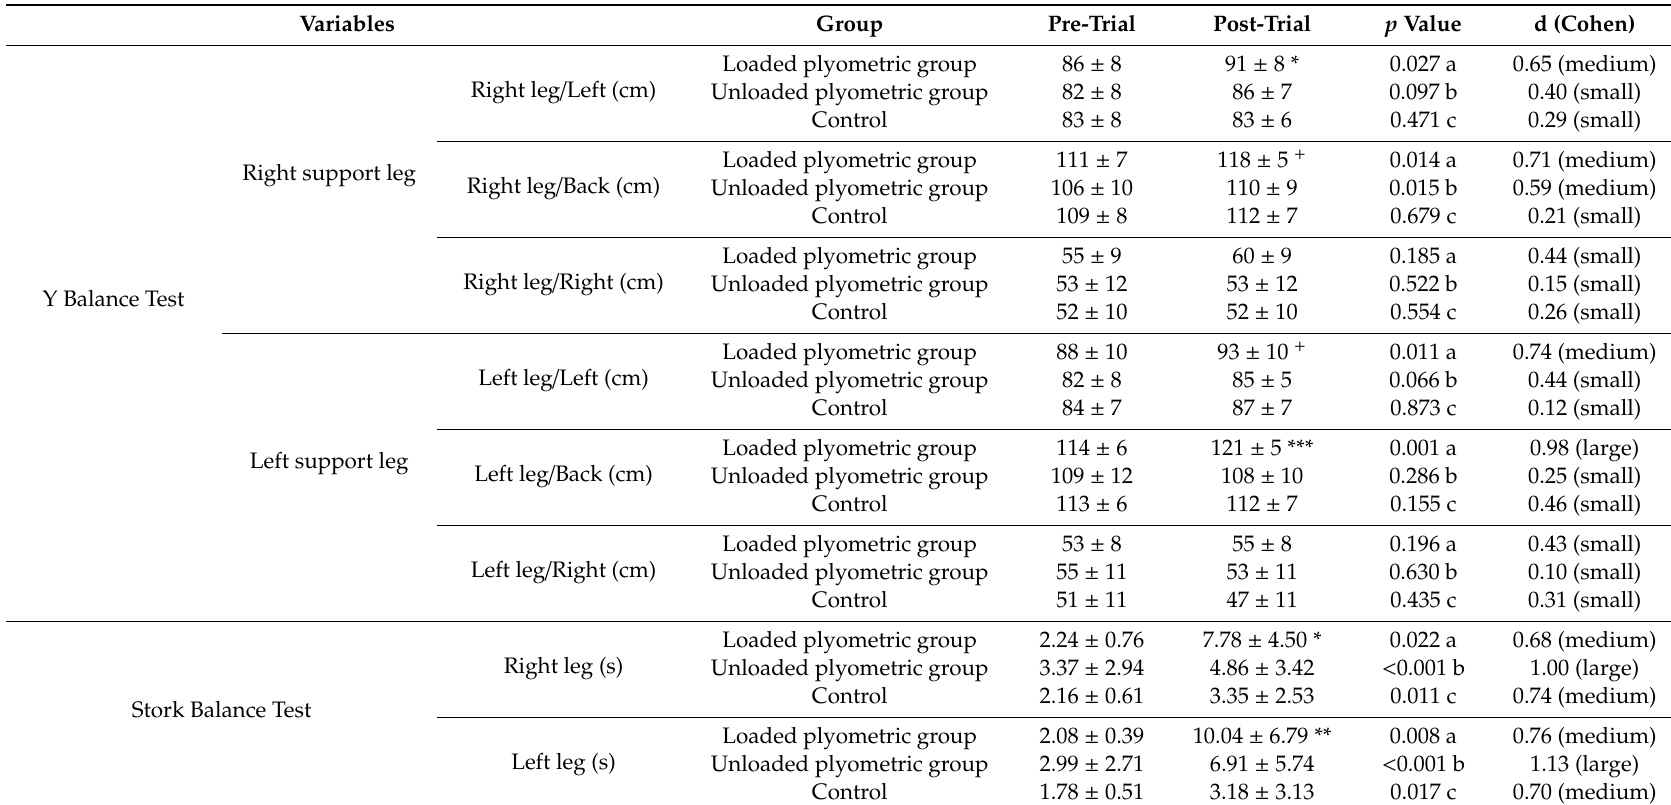
Table 6. Comparison of balance performance between groups before (pre) and after (post) the 10-week